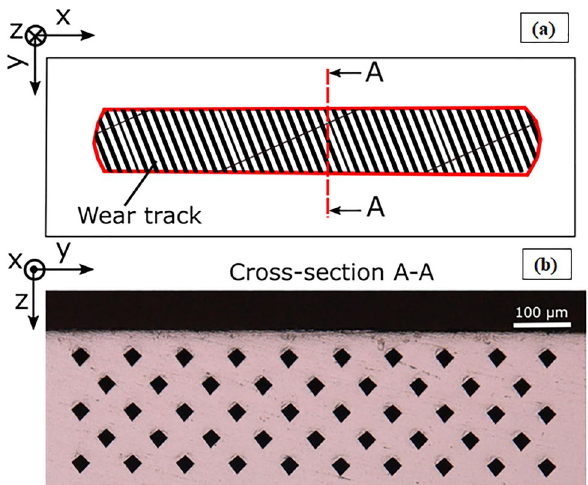
Figure 1. Schematic of wear track showing the position of the cross-section ( a ), an optical micrograph of the hardness mapping showing the footprint of the idents in the cross-section ( b )